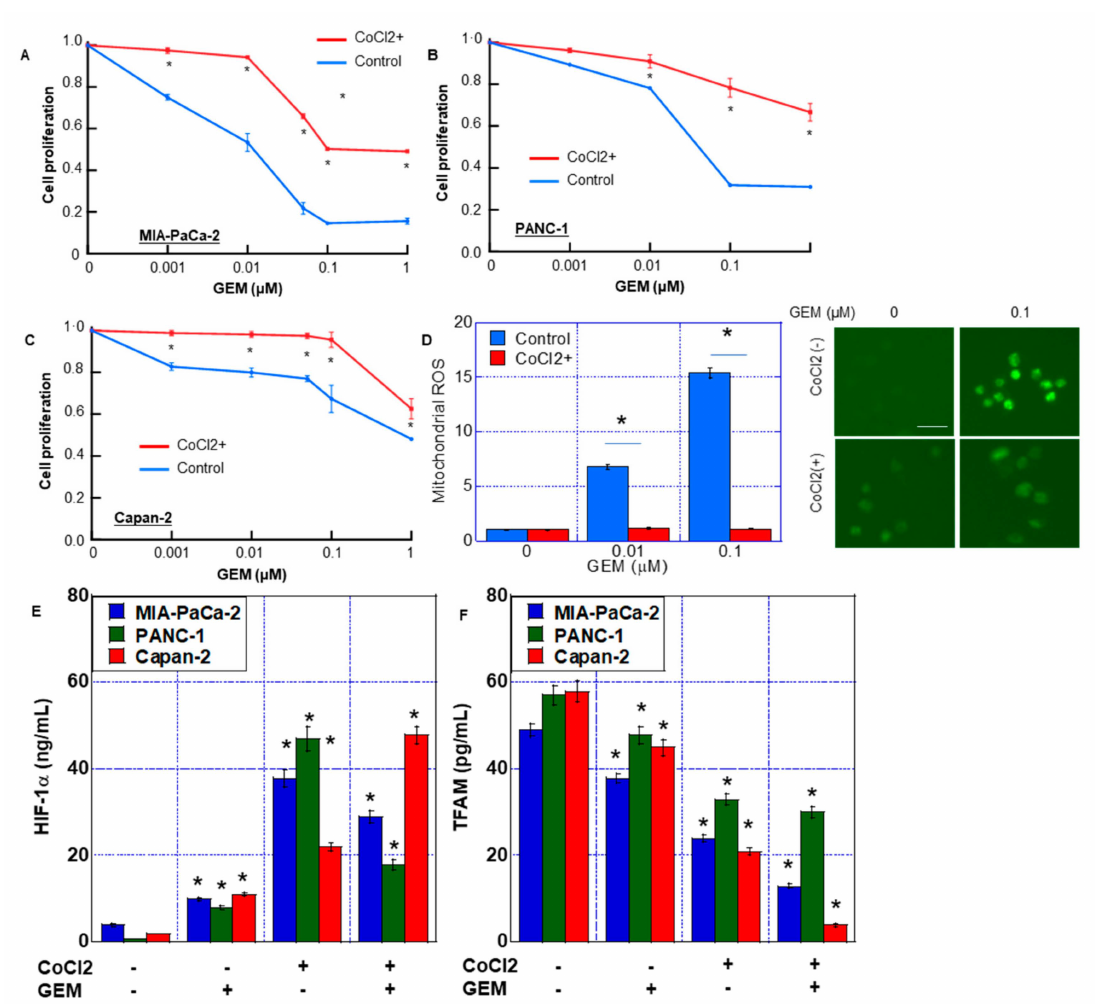
Figure 1. GEM resistance induced by CoCl 2 in MIA-PaCa-2 PDA cells. ( A – C ) Effect of CoCl 2 on cell proliferation in MIA-PaCa-2 ( A ), Panc-1 ( B ) and Capan-1 ( C ). Cells were treated with CoCl 2 (150 µ M) and GEM for 72 h. ( D ) ROS production was examined by DHR in MIA-PaCa-2. (Right) Fluorescence images of DHR. Scale bar, 50 µ m. ( E , F ) HIF-1 α and TFAM levels in MIA-PaCa-2, Panc-1 and Capan-1. Cells were treated with or without CoCl 2 (150 µ M) and GEM (0.1 µ M). Error bars represent the standard deviations from three independent examinations. * p < 0.05. ( E , F ) vs. CoCl 2 (-)/GEM(-). Statistical differences were calculated by ordinary analysis of variance. GEM, gemcitabine; PDA, pancreatic ductal adenocarcinoma; ROS, reactive oxygen species; DHR, dihydrorhodamine 123; HIF, hypoxia-inducing factor; TFAM, transcription factor A